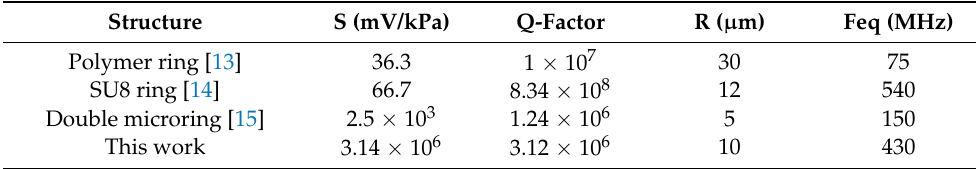
Table 2. Sensitivity analysis of microring acoustic wave